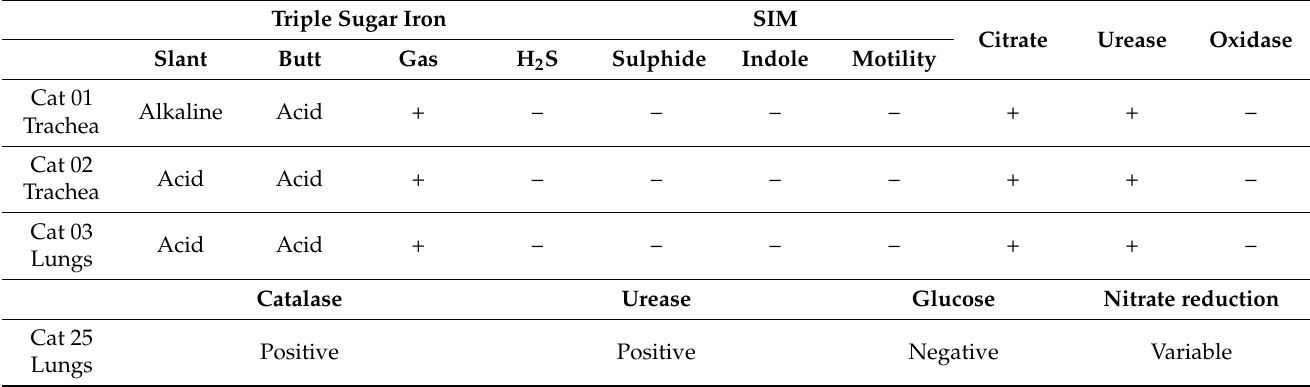
Figure 5. Conventional biochemical testing results of ( a ) K. pneumoniae and ( b ) R. equi , isolated from trachea and pleural effusion samples of two cats investigated for acute/chronic infectious respira ‐ tory disease signs.